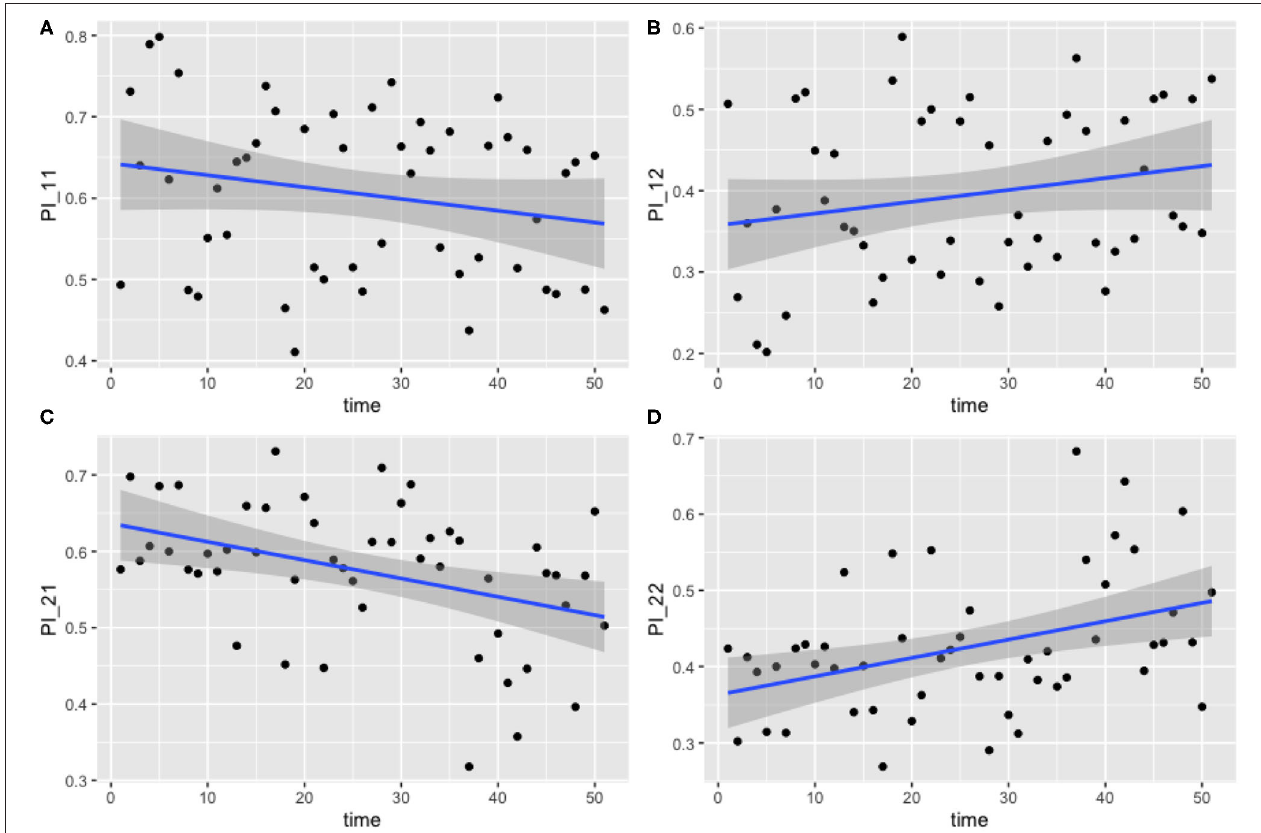
FIGURE 4 | Transition probabilities between two states, “uncolonized” and “colonized.” Plots show (A) π 1,1, t , (B) π 1,2, t , (C) π 2,1, t , and (D) π 2,2, t against time. Each point is the calculated transition probability for that time point. Also plotted is a linear regression against these points in blue, with a shaded region depicting the 95% confidence interval of the regression. (C,D) Are significant ( p <